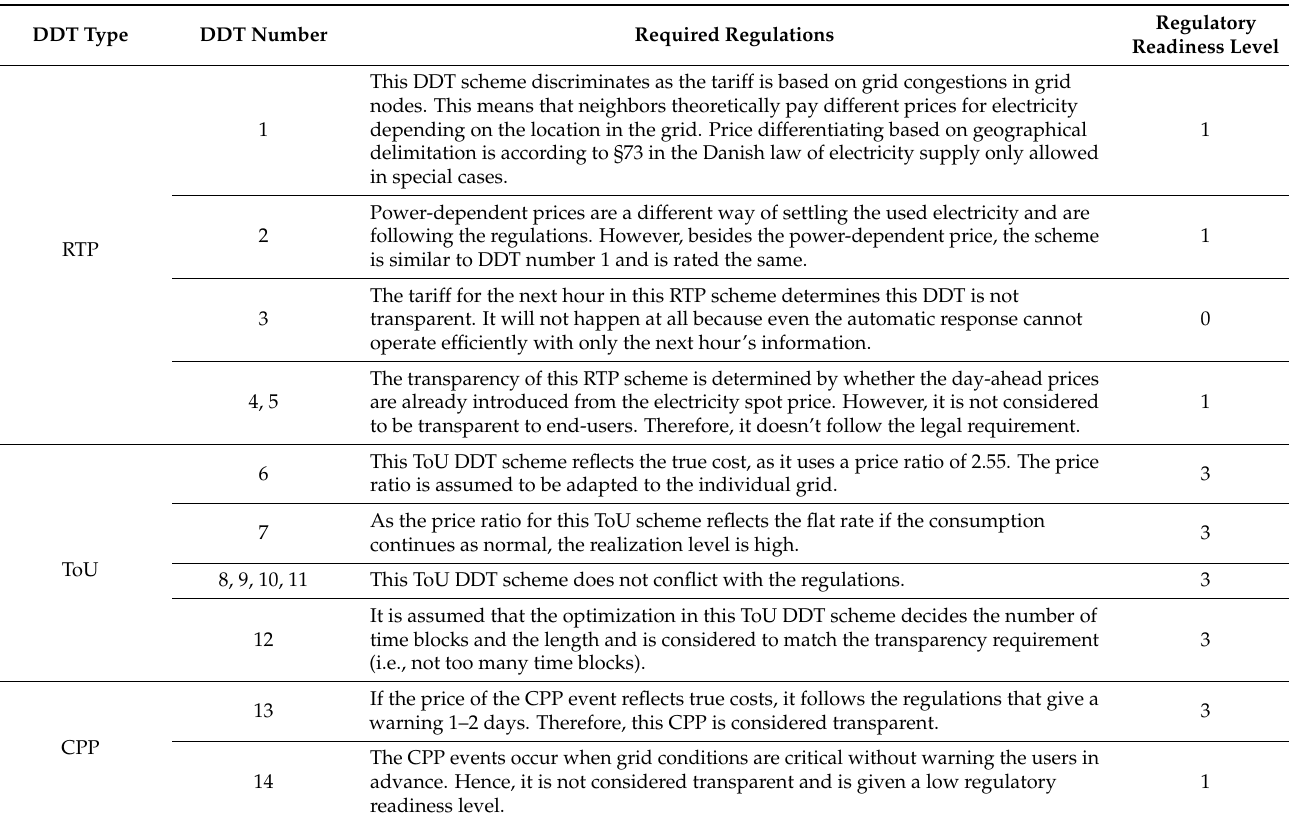
Table 8. Required regulations for each relevant DDT